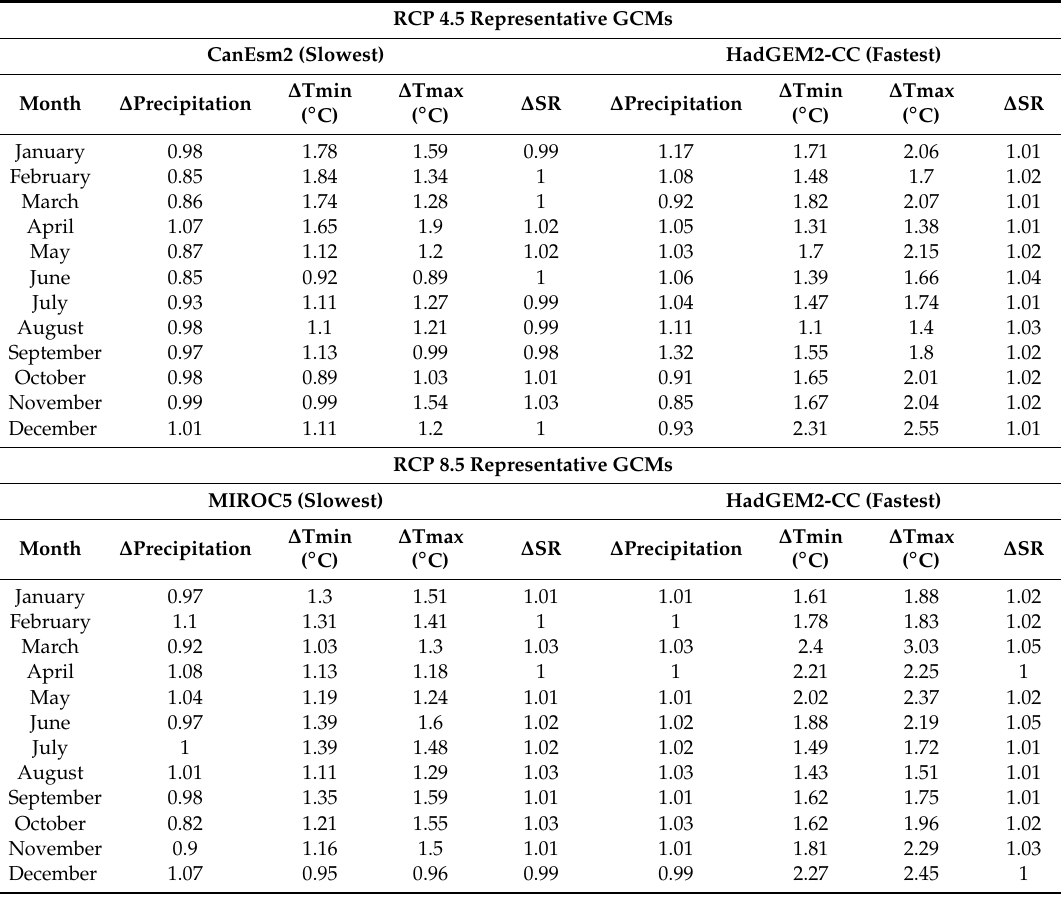
Table 2. The change factors projected by the slowest and fastest salt transport schemes of the representative General Circulation Models (GCMs): the relative change in precipitation ( ∆ Rain), the absolute changes in the minimum and maximum daily temperature ( ∆ T min , ∆ T max ), and the relative change in solar radiation ( ∆ SR). The baseline climatology is the long-term (1960–2016) mean values for each of the twelve months (as summarized in Table 3 below).